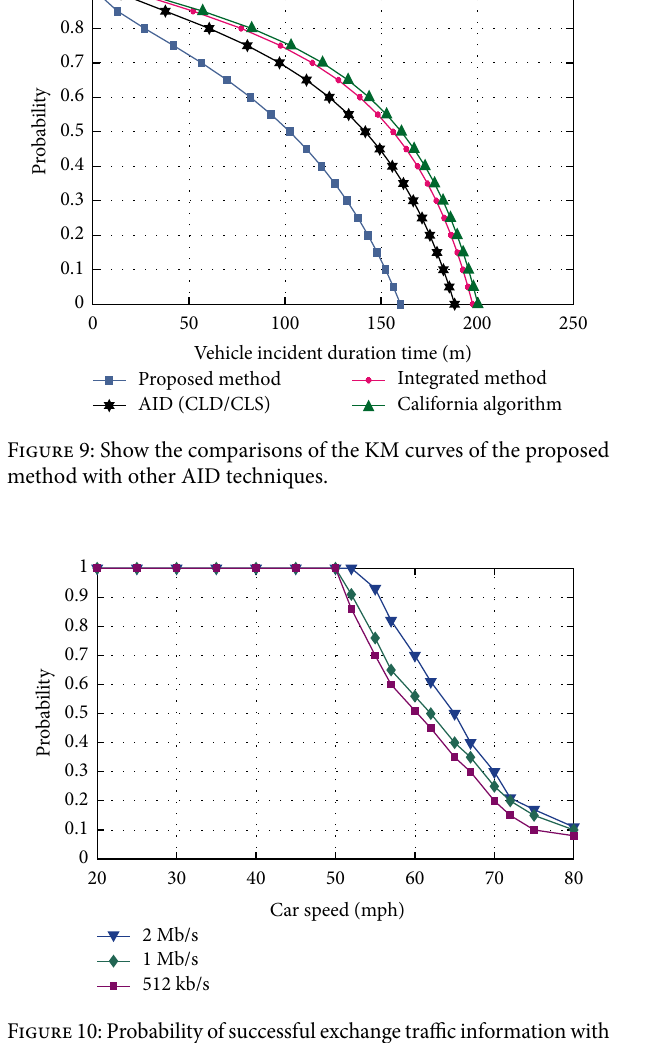
Figure 10: Probability of successful exchange traffic information with different data rates.